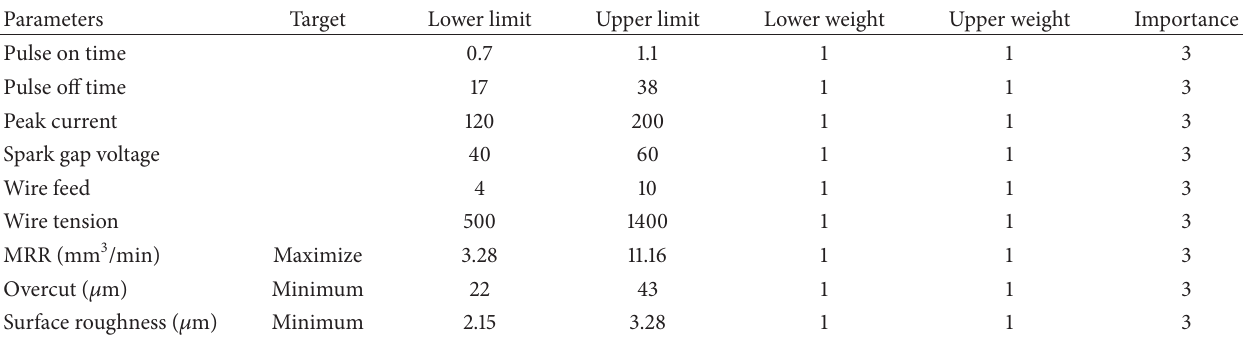
Table 7: Constraints of input parameters and